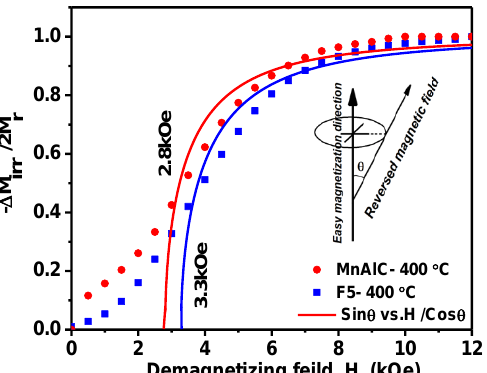
Figure 7. Irreversible magnetization vs applied reversal field for Mn-Al-C and F5 samples.